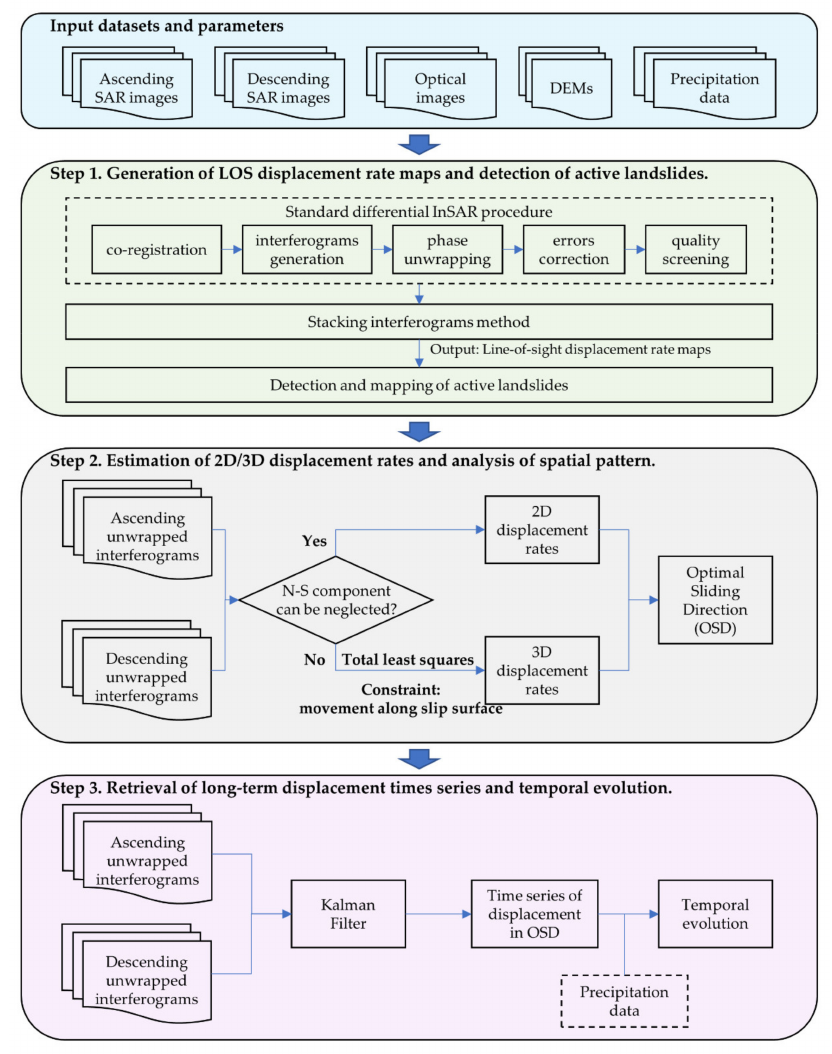
Figure 3. Workflow of InSAR-driven landslide detection and Total Least Squares–Kalman Filter-based approach for three-dimensional displacement rates and long-term time series estimation of